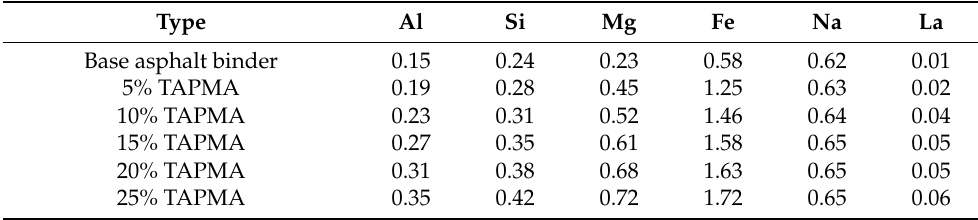
Table 4. Heavy metal leaching results (leaching concentration ( µ